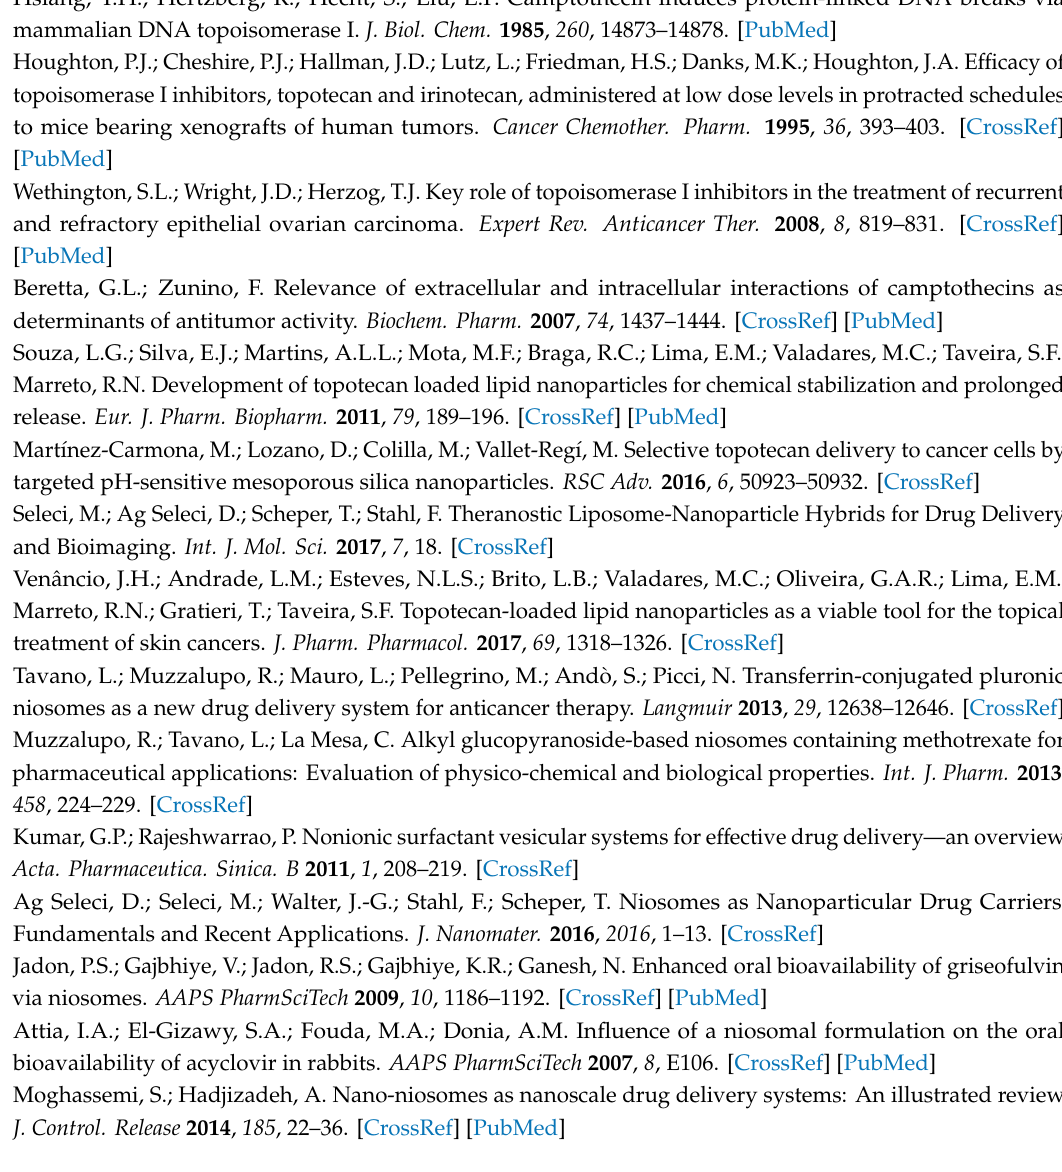
Figure S1: TEM micrograph of niosomes stained with 2% phosphotungstic